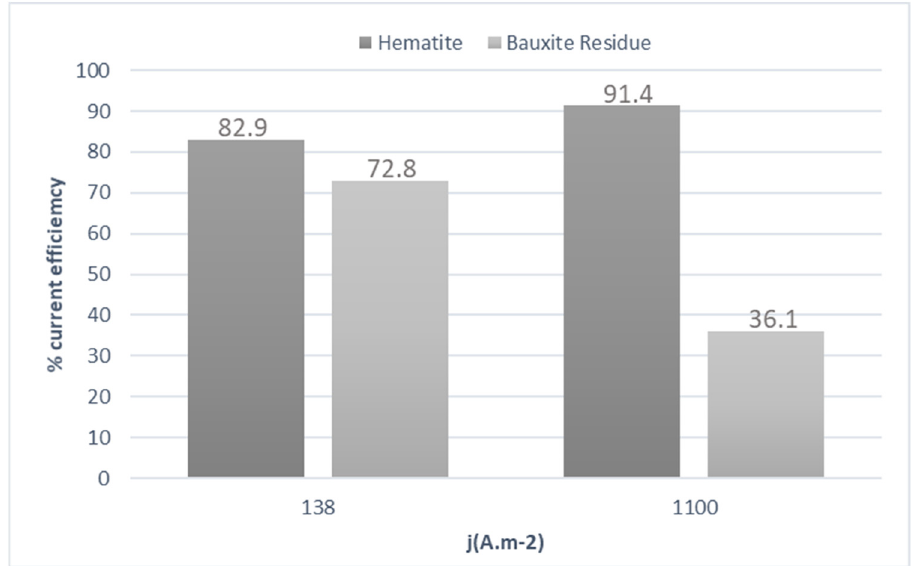
Figure 3. Current efficiency as a function of current density for hematite and bauxite residue.